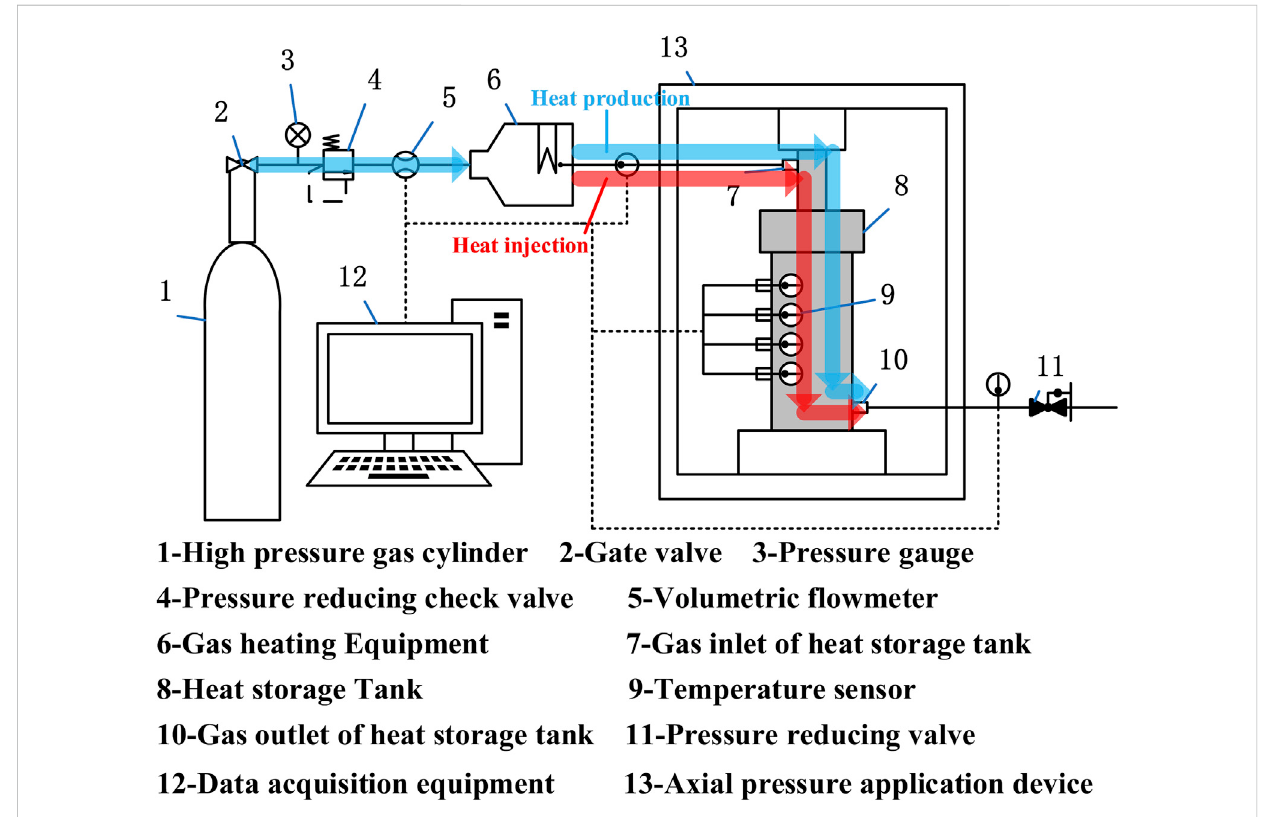
FIGURE 1 Schematic diagram of the experimental